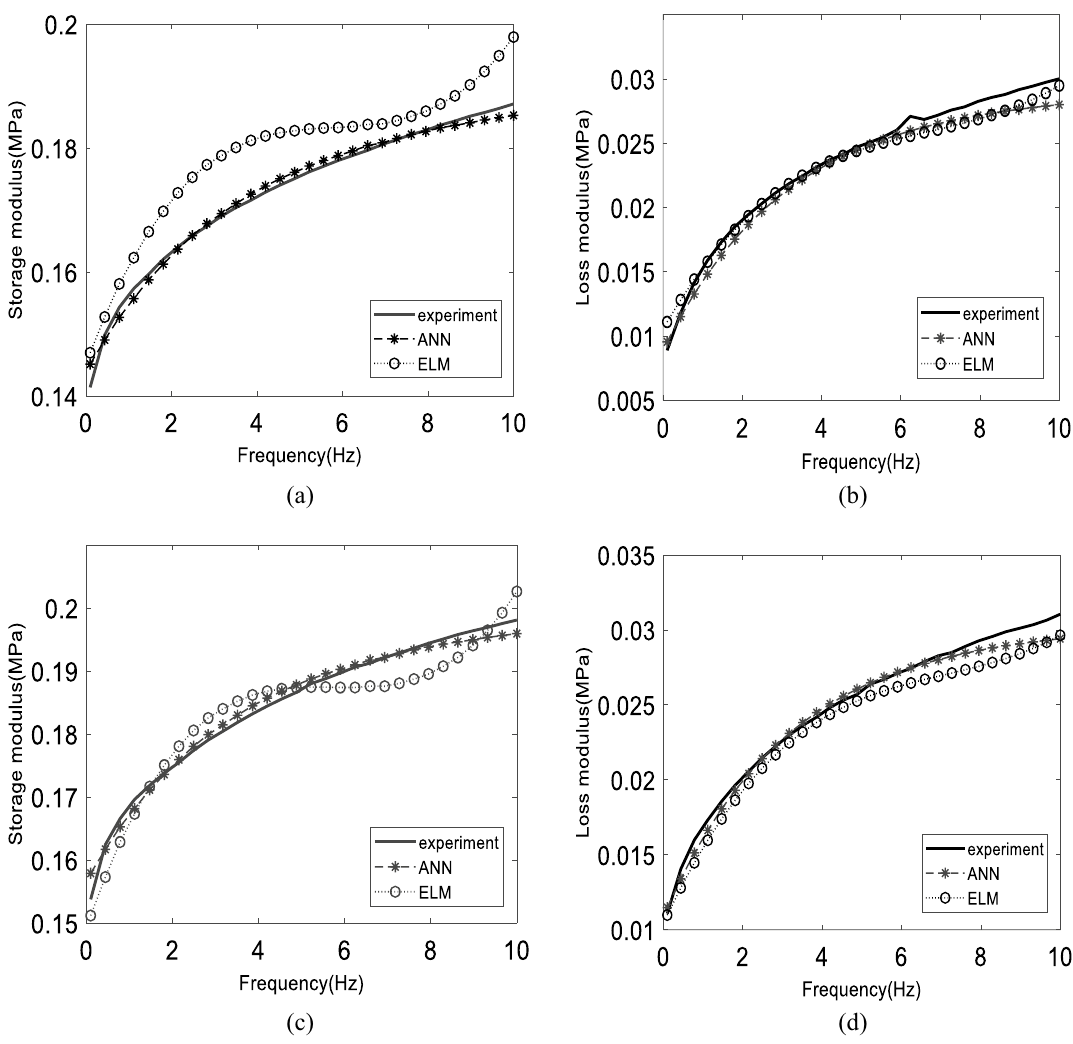
Figure 5. The comparison of dynamic modulus between experimental, ANN, and ELM model for Ts2 data at 0.58 T, 30% where ( a ), ( b ) for isotropic distribution and ( c ), ( d ) for anisotropic